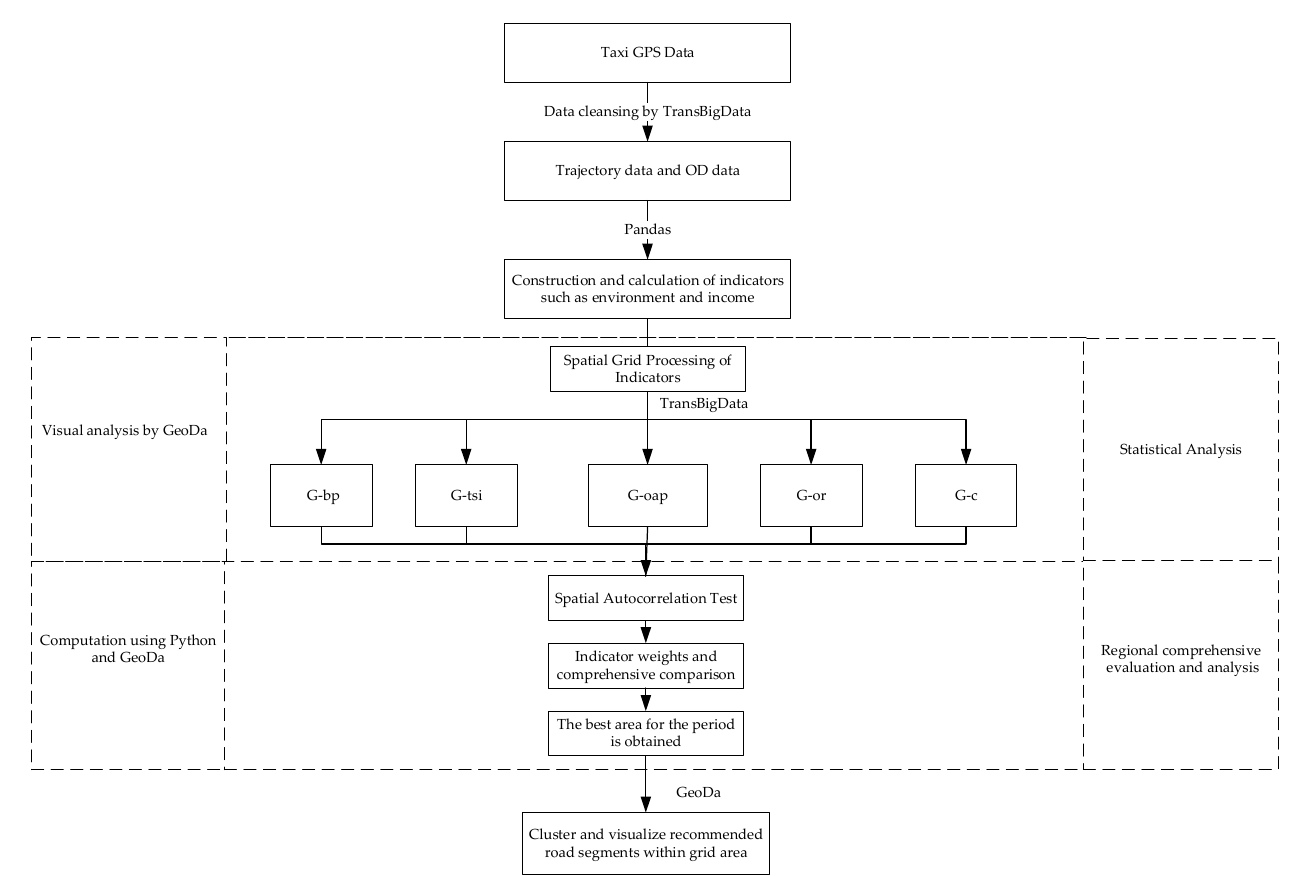
Figure 1. Research Framework.